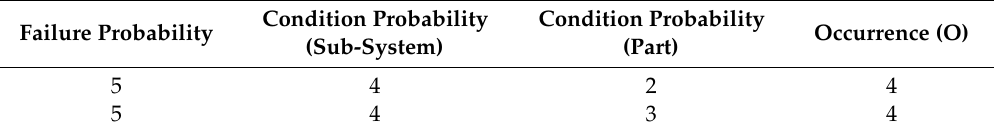
Table 14. Excerpt of IF-THEN rules for the Occurrence (O) index.